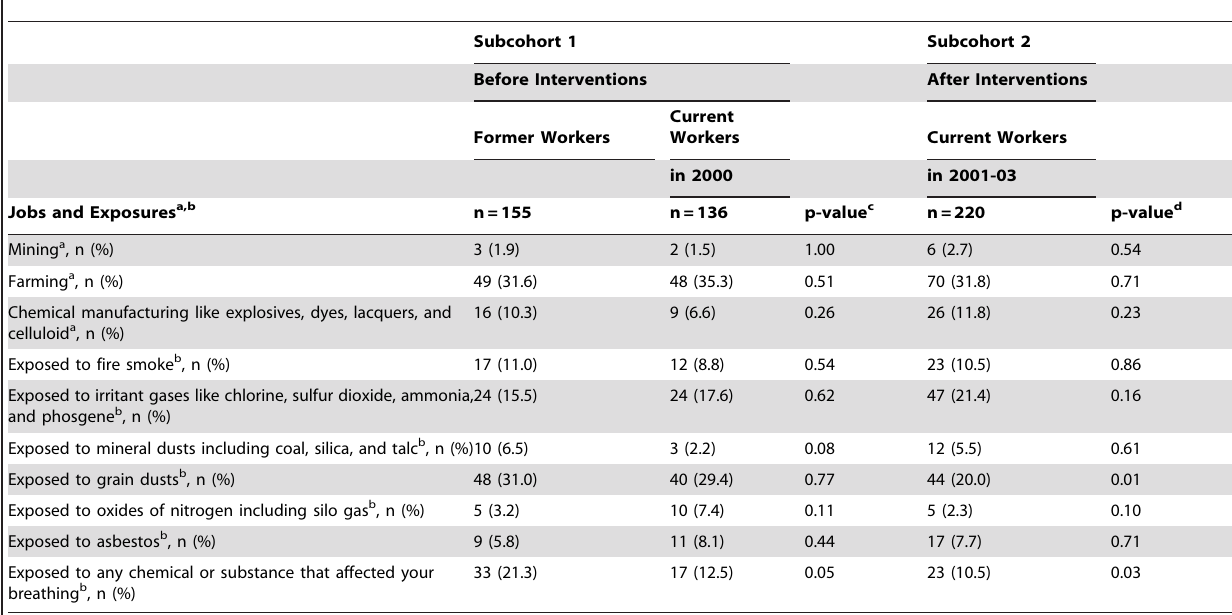
Table 2. Reported jobs and exposures prior to employment at Missouri microwave popcorn manufacturing